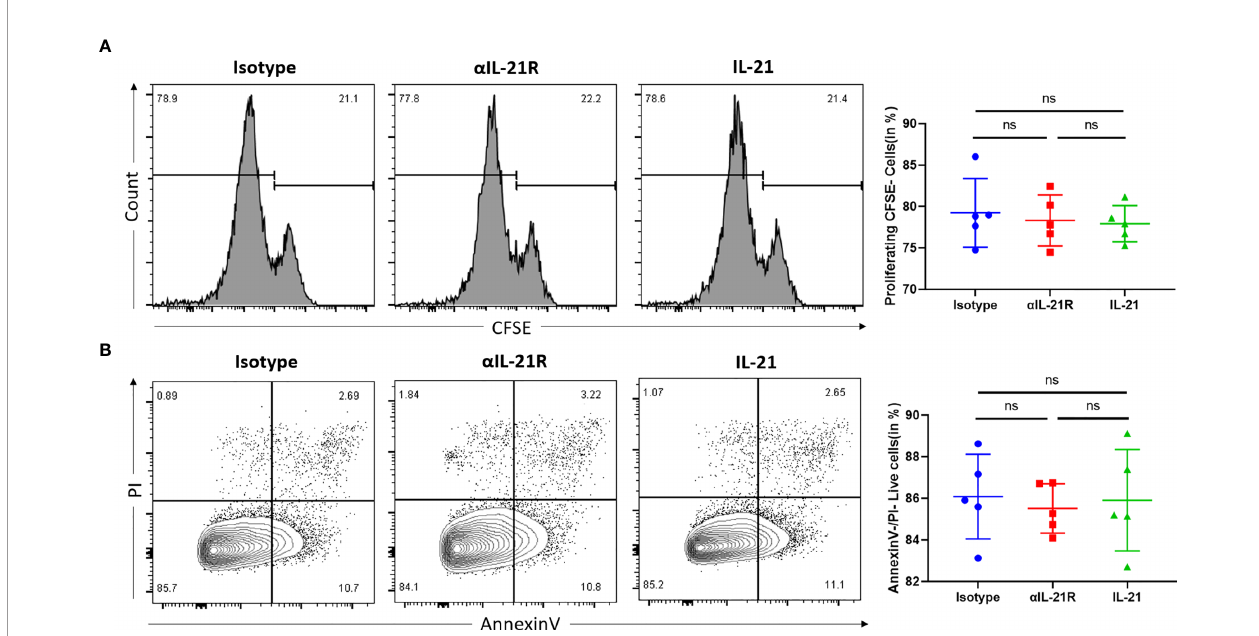
FIGURE 1 | a IL-21R does not alter CD4+ T cell proliferation and apoptosis under Th0 conditions. (A) Naïve CD4+ T cells were isolated from C57BL/6 mice and labeled with 1 m M CFSE. Naïve CD4+ T cells were activated with anti-CD3/anti-CD28 to induce proliferation. Proliferation of naïve CD4+ T cells was measured by the dilution of CFSE, in the presence of 10 m g/ml a IL-21R or Isotype control. (B) Naïve CD4+ T cells from C57BL/6 mice were activated with anti-CD3/anti-CD28 under the condition of 10 m g/ml a IL-21R or Isotype control. Lived cell was measured by the frequency of Annexin V - PI - cells. Column plots display individual data points and mean ± SD, n = 5/group. ns, not signi fi